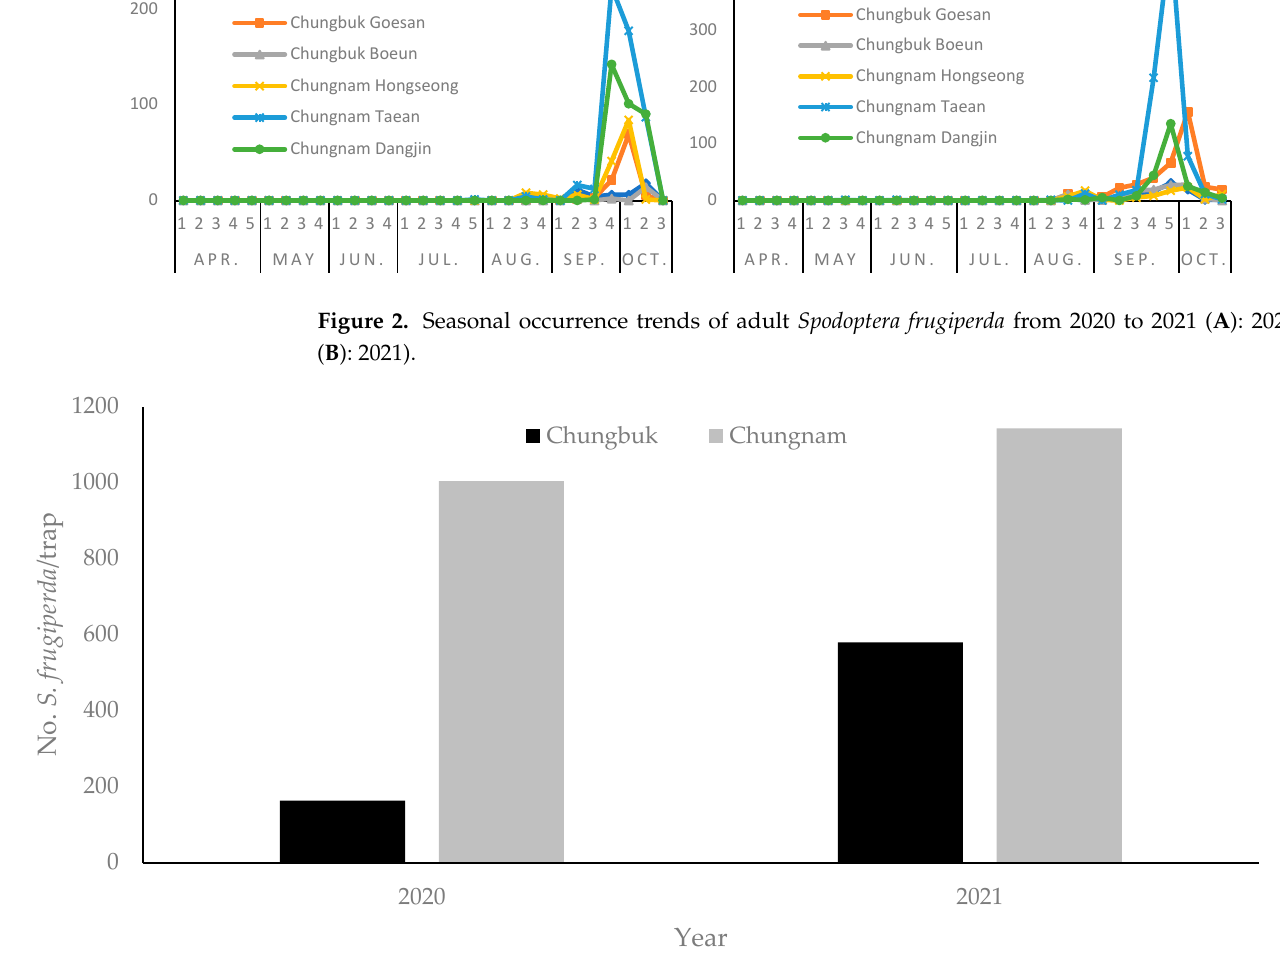
Figure 3. Comparison of adult Spodoptera frugiperda occurrence in Chungcheongbuk-do (Chungbuk) and Chungcheongnam-do (Chungnam) from 2020 to 2021.